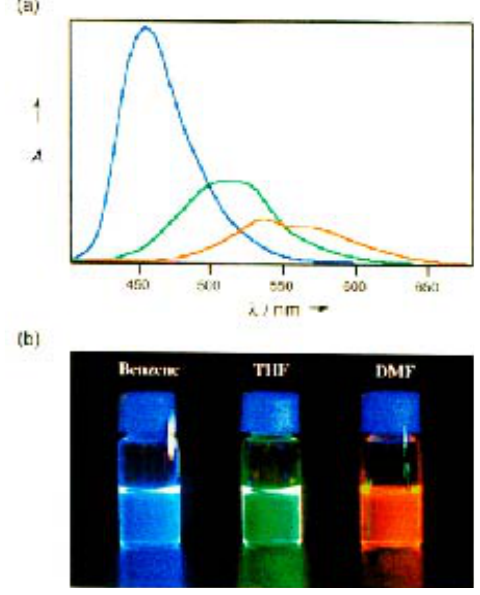
Figure 8. Fluorescence of 10d : (a) The emission spectra in various solvents (benzene, blue line; THF, green line; DMF, orange line) and (b) a picture of the solutions under irradiation of light at 365 nm. The spectrum in DMF is magnified 10  in intensity [43]. (Copyright 2000, reprinted with permission of Org.